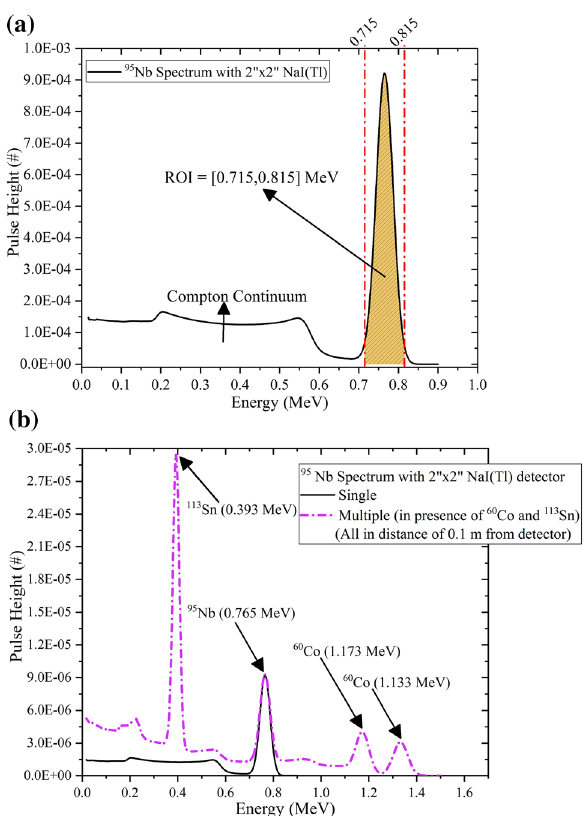
Figure 4. ( a ) MCNPX-simulated spectrum (per particle) of a single isotropic 95 Nb gamma-ray source in distance of 1 cm of Ø2 ″ × 2 ″ cylindrical NaI(Tl) scintillation detector. ( b ) MCNPX-simulated spectrum (per particle) of an isotropic 95 Nb gamma-ray source in presence of a 113 Sn and a 60 Co (multiple sources scenario), all in distance of 10 cm of Ø2 ″ × 2 ″ cylindrical NaI(Tl) scintillation